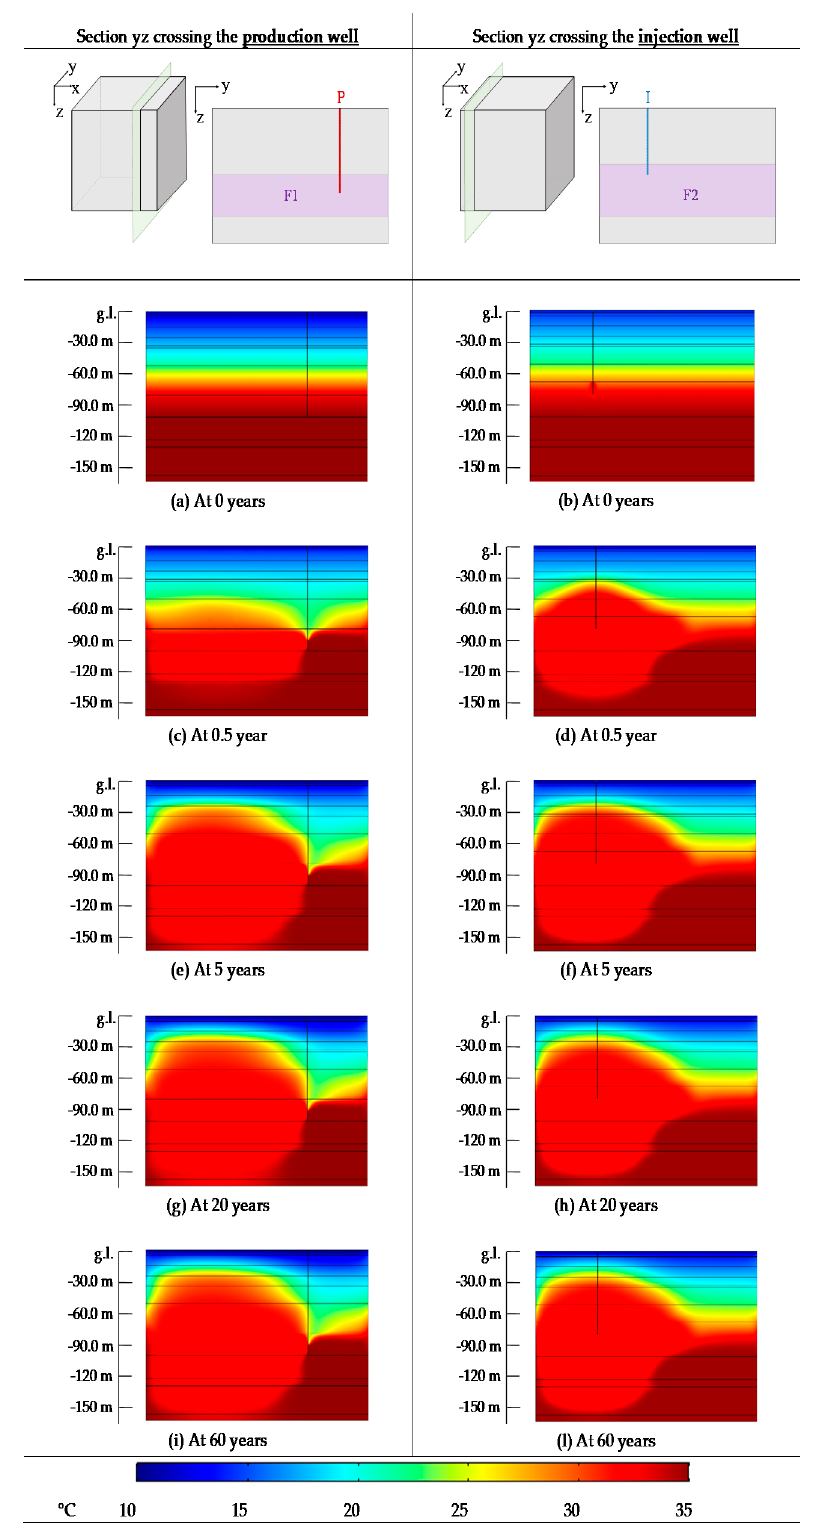
Figure 10. Temperature field of the sections yz crossing the wells, at different times, for Case 2 (double faults).